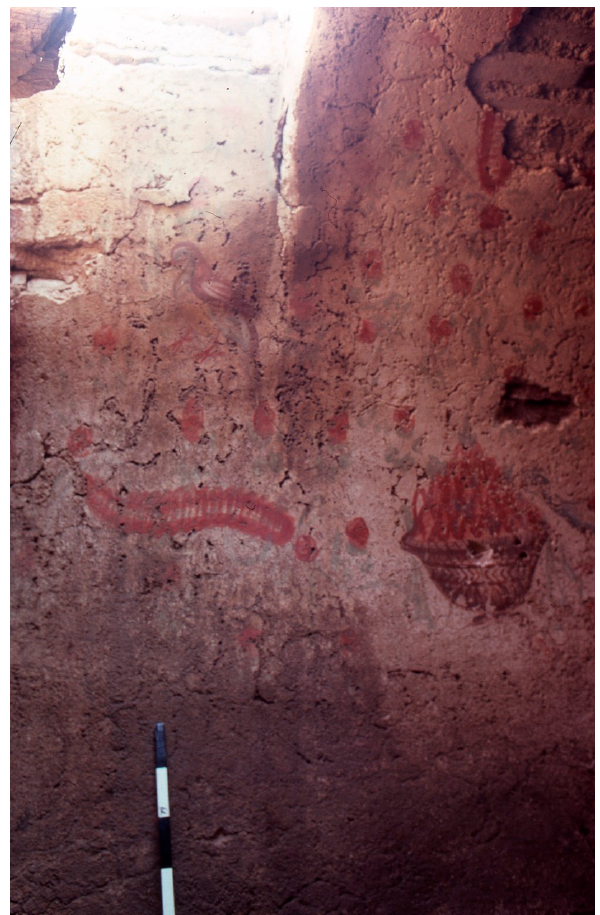
Figure A9. Sardis, Tomb 79.2 (Appendix A.6), east wall. © Archaeological Exploration of Sardis/President and fellows of Harvard College.